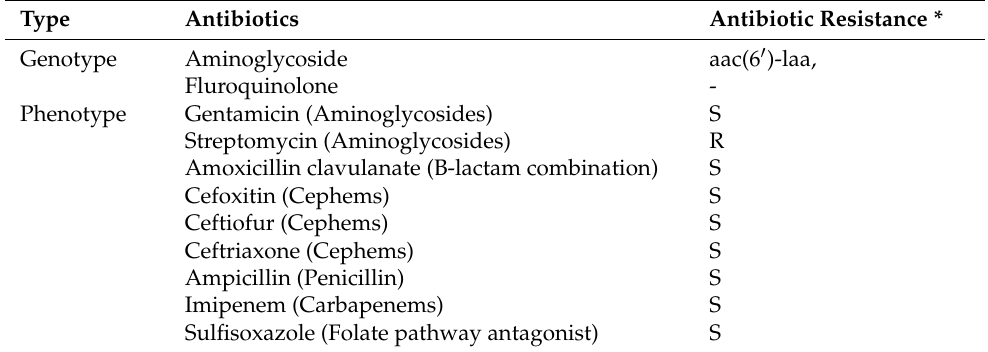
Table 1. Antibiotic resistance phenotype and genotype of S. houtenae str.20-369 isolate of this